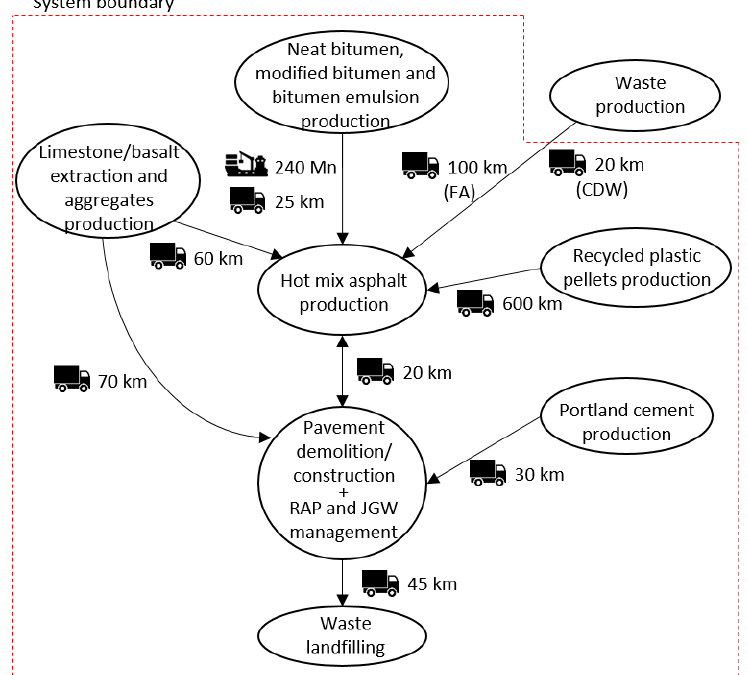
Figure 2. Overview of the facilities involved in the system boundary (considering all the possible phases of the life cycle) and relative transportation distances of the case study.